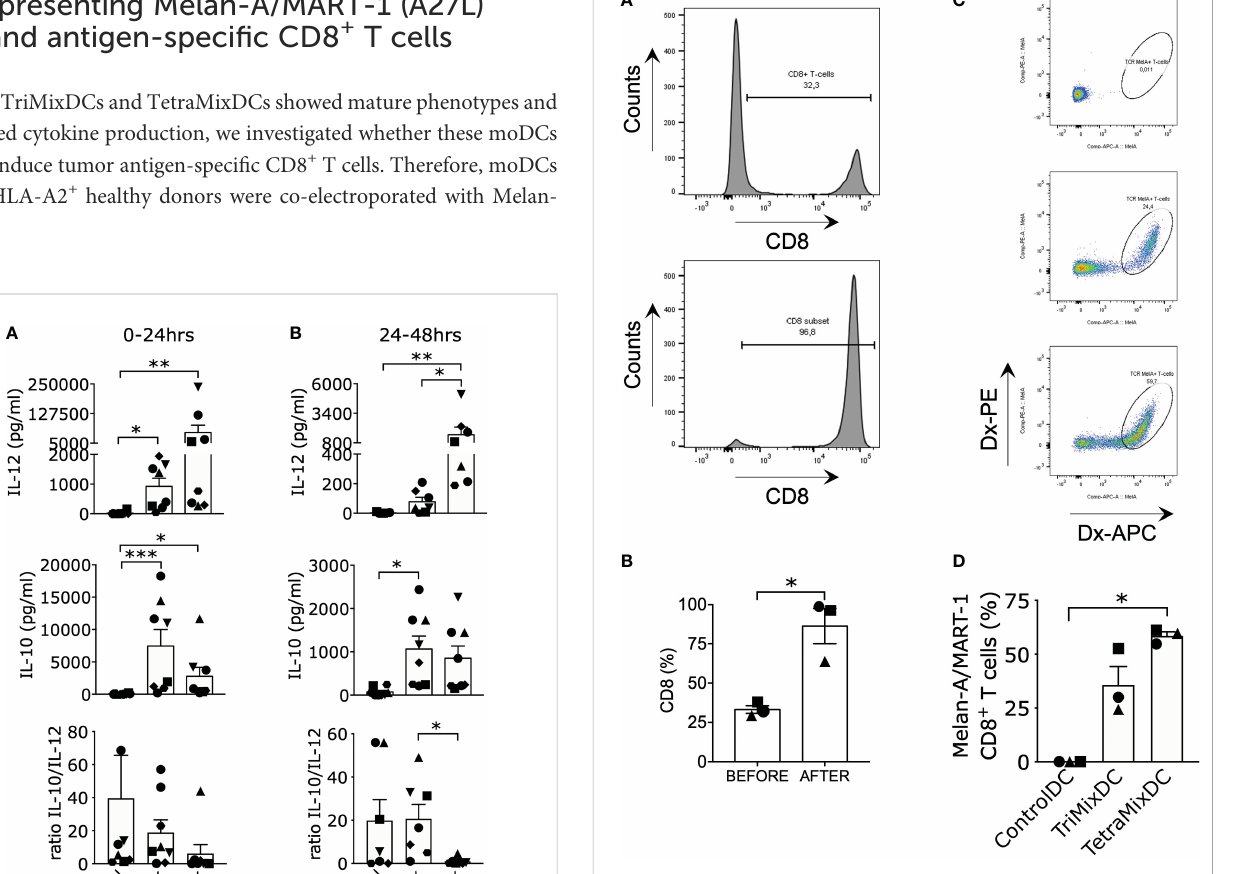
FIGURE 6 TetraMixDCs generate Melan-A/MART-1-speci fi c T cells from bulk CD8 + autologous T cells. Dendritic cells co-electroporated with TriMix mRNA or TetraMix mRNA and Melan-A/Mart-1 mRNA were co- cultured with sorted autologous CD8 + T cells. DCs electroporated with tNGFR were used as negative control. (A) Histograms showing the shift in CD8 + T cell percentage prior (upper graph) and post (lower graph) CD8 + T cell isolation (representative data). (B) The bar graph represents the purity of CD8 + T cells prior (left bar) and after (right bar) CD8 + T cell isolation. (C) Flow cytometry gating strategy for double positive dextramer staining of Melan-A/MART-1-speci fi c CD8 + T cells. (D) The bar graph represents the percentage of Melan-A/MART-1- speci fi c CD8 + T cells at the end of the stimulation assay (21 days, weekly stimulation, total of 3 stimulation rounds). Results are shown as mean value ± standard error of the mean for 3 independent experiments (n=3). Each symbol represents the data of an individual donor. Statistical signi fi cance is indicated as follows: *p < 0.05, by Friedman ’ s